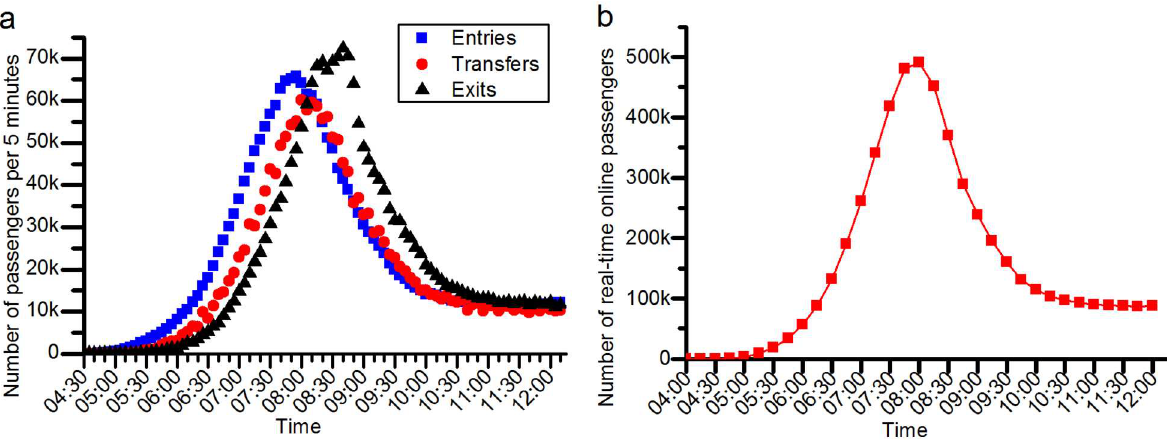
Fig 13. Online passengers in the rail transit network. (a) represents the total entries, transfers and exits of the rail transit networkat every 5 minutes. (b) shows the numberof instantaneous passengers on the rail transit network at the end of each simulationperiod. The numberof passengers reachesits peak, namely, 490,397, at end of the simulationperiod[8:15, 8:30). The simulationresults are computed in the normal situationwith no station closure.